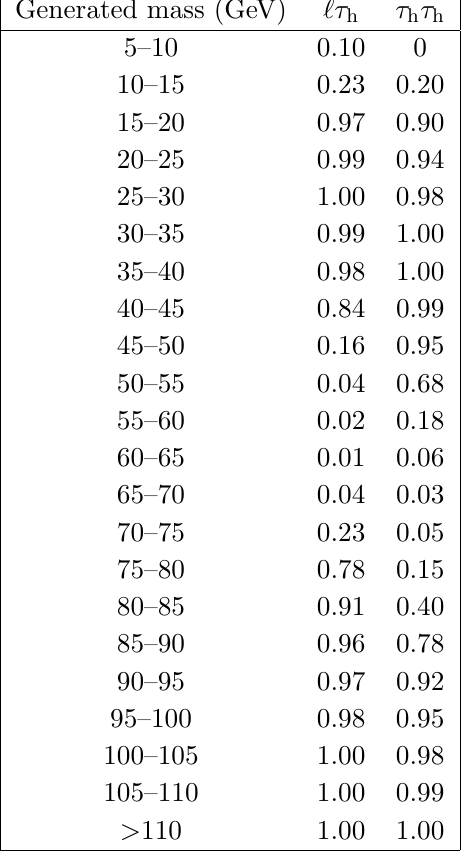
Table 11 . E(cid:14)ciencies of the M T2 > 90 GeV requirement in all channels versus generated M T2 .